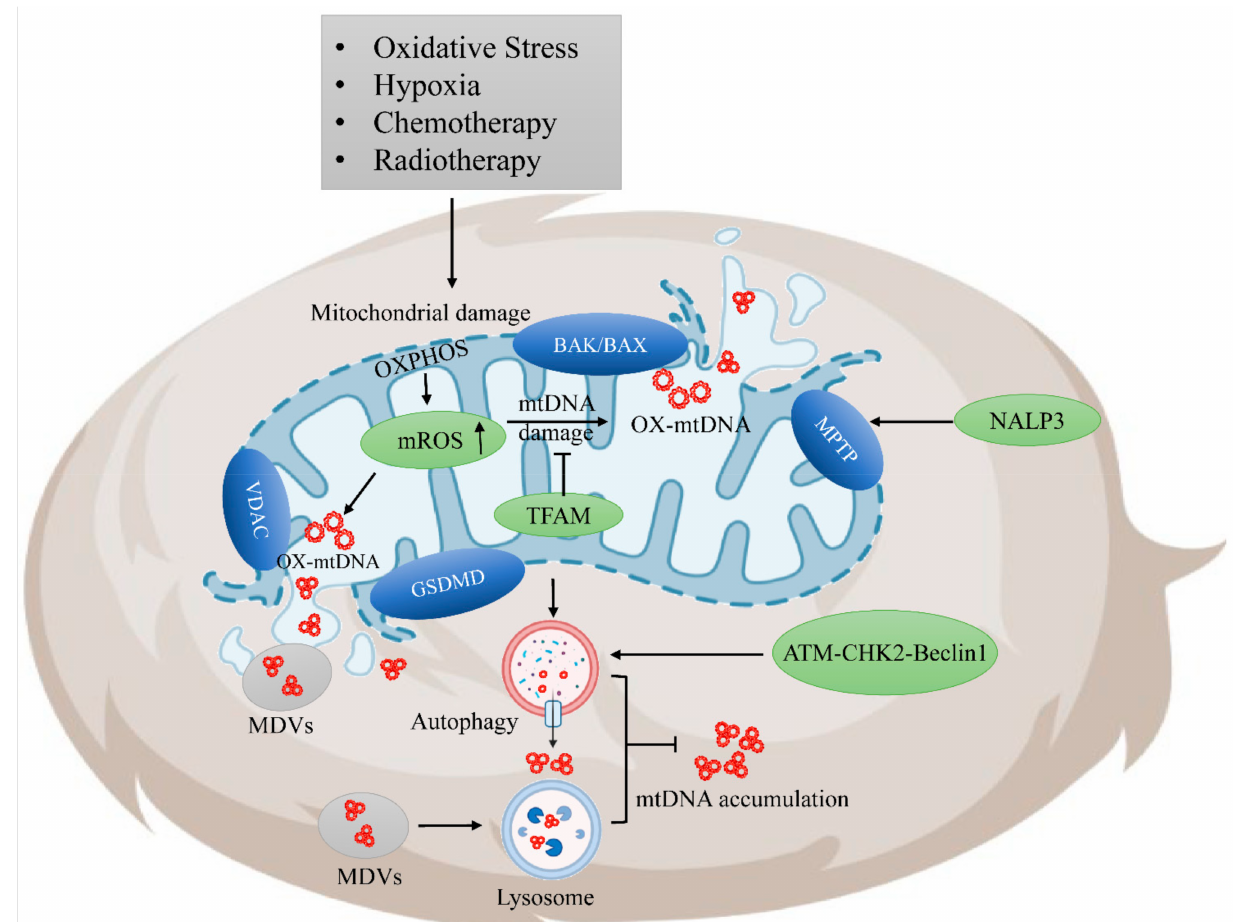
Figure 1. Regulation of tumor-derived mitochondrial DNA release. Damaged mitochondrial DNA (mtDNA) is released into the cytoplasm through mitochondrial membrane channels: When cells are exposed to exogenous radiotherapy, chemotherapy, or oxidative stress, reactive oxygen species (ROS) in the mitochondria increases dramatically, and damaged mtDNA is released into the cytoplasm in the form of ox-mtDNA fragments or mitochondrial-derived vesicles (MDVs) transport. The release of mtDNA depends on the mitochondrial permeability transition pore (MPTP) in the inner membrane of the mitochondria, which is partly formed by voltage-dependent anion channel (VDAC) oligomers in the outer membrane. Activation of the apoptotic protein Bcl-2 homologous killer/Bcl-2-associated X protein (BAK/BAX) can induce destruction of the mitochondrial outer membrane network,